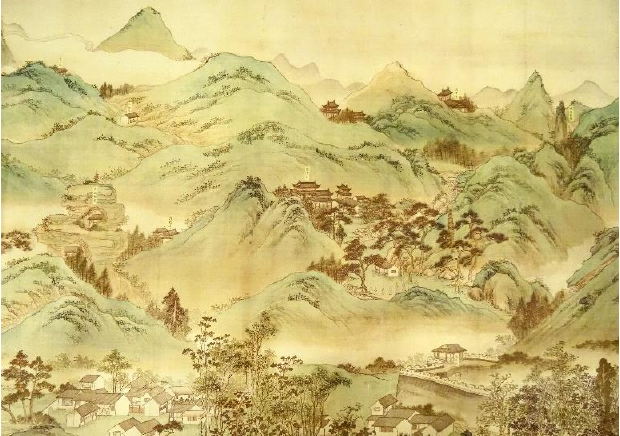
Figure 4. Drawing of Guoqing Si in Qing Dynasty.